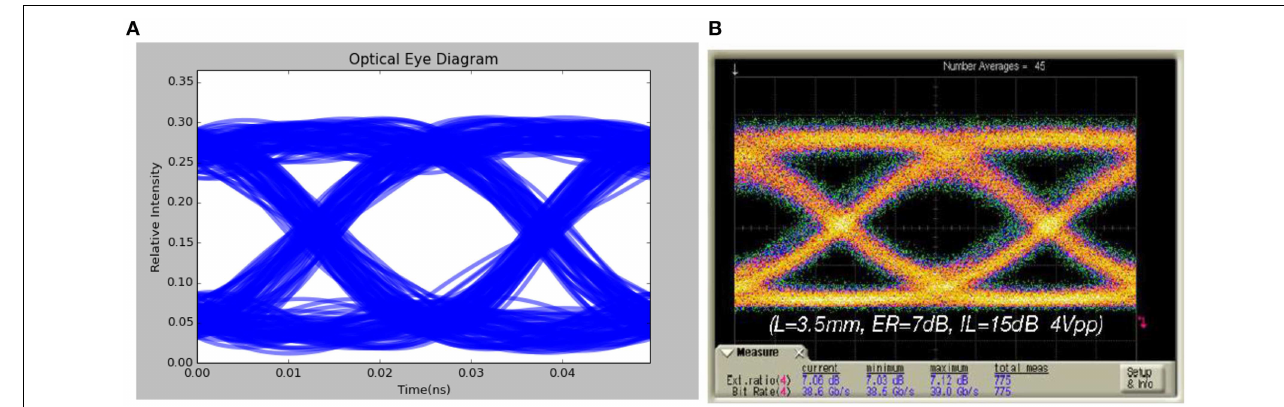
FIGURE 6 | (A) Mod1 Eye diagram simulated with 3.5mm MZM, 40 Gbps 4V peak-to-peak RF signal input. (B) Eye diagram derived from optical PRBS data output at 40 Gbit/s. 3.5mm MZI with 4V RF signal operated at quadrature (7dB ER).